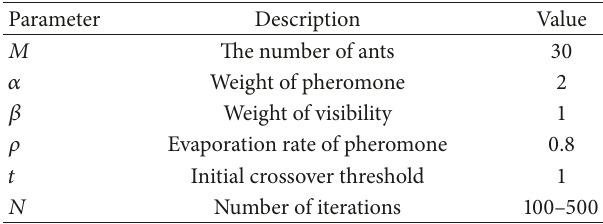
Table 1: E-ACO parameters